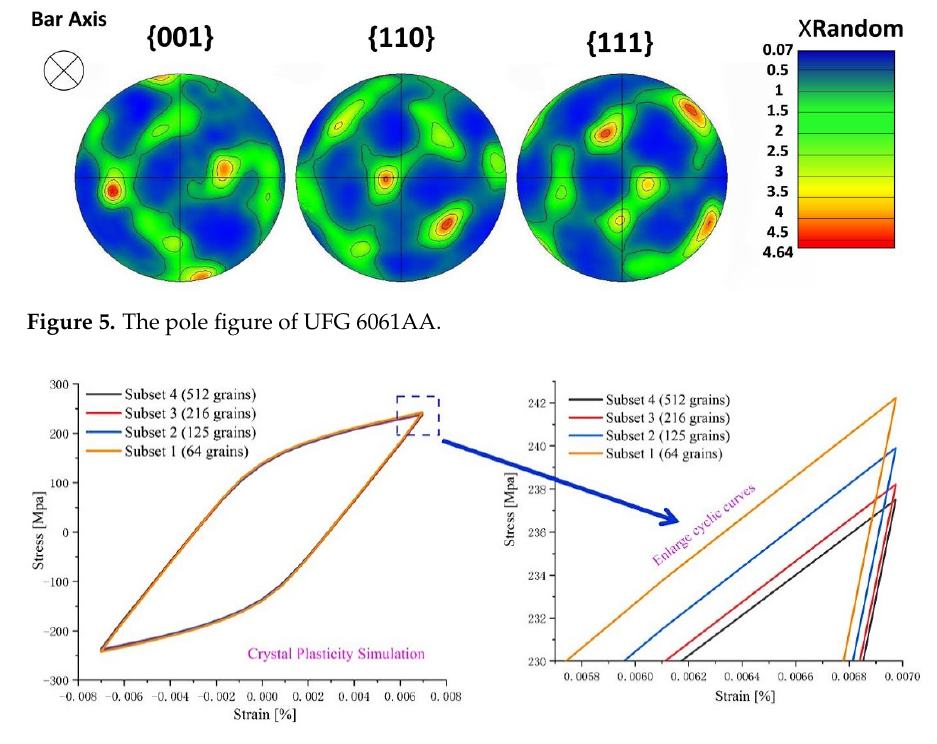
Figure 6. Comparison between the steady hysteresis loops under repeated load and the mechanical response from the polycrystal FE model simulated with different numbers of grains.